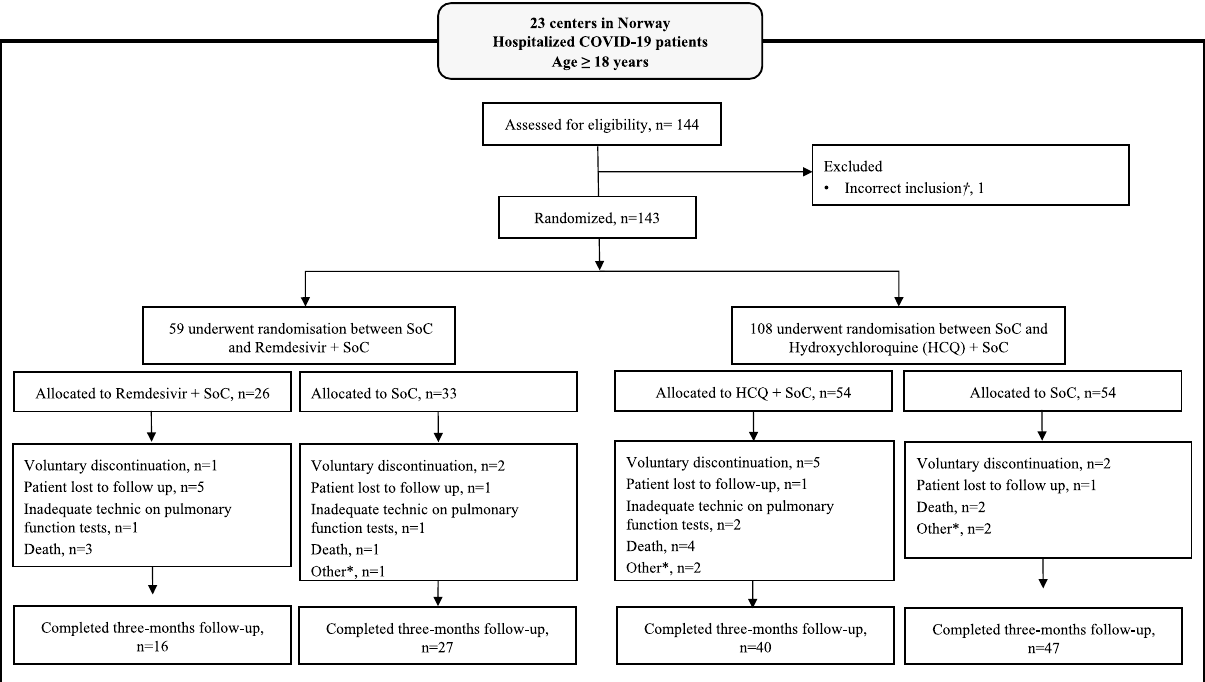
Figure 1. Flow chart of the participant flow. *Other: Emigration, progression of cancer diseases, general health deterioration, prolonged corrected QT-time during treatment with HCQ; † Excluded from the full analysis set. HCQ